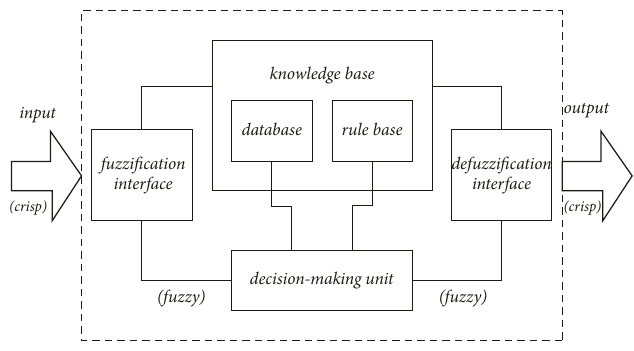
Figure 6: The general model of a fuzzy